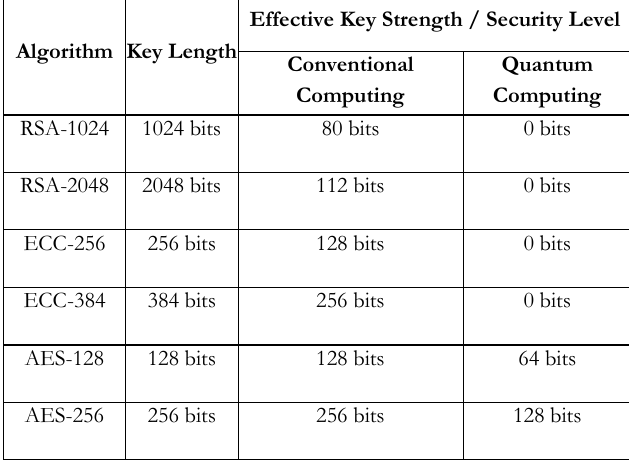
Table 2. Comparison of conventional and quantum security levels of typical ciphers